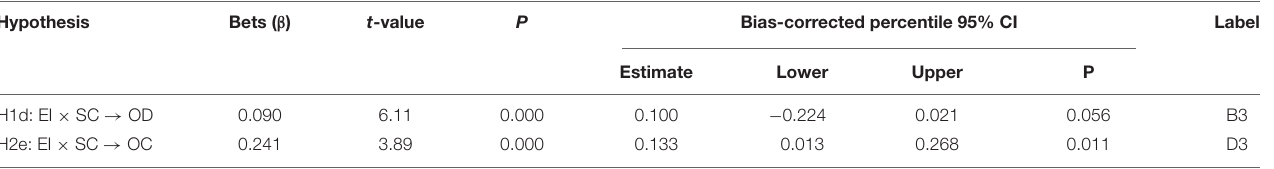
TABLE 5 | Indirect and conditional effects (robust model).